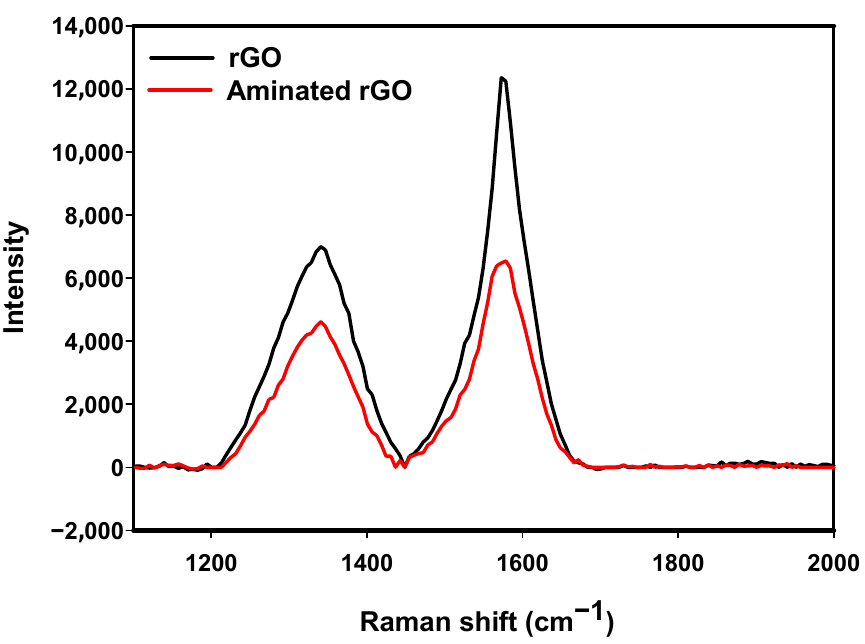
Figure 1. Raman spectra obtained from a bare reduced graphene oxide (rGO) electrode and rGO electrode incubated in ammonium hydroxide. Both the G (1578 cm − 1 ) and D (1340 cm − 1 ) bands decreased and broadened after rGO amination while the I D / I G ratio increased from 0.6 to